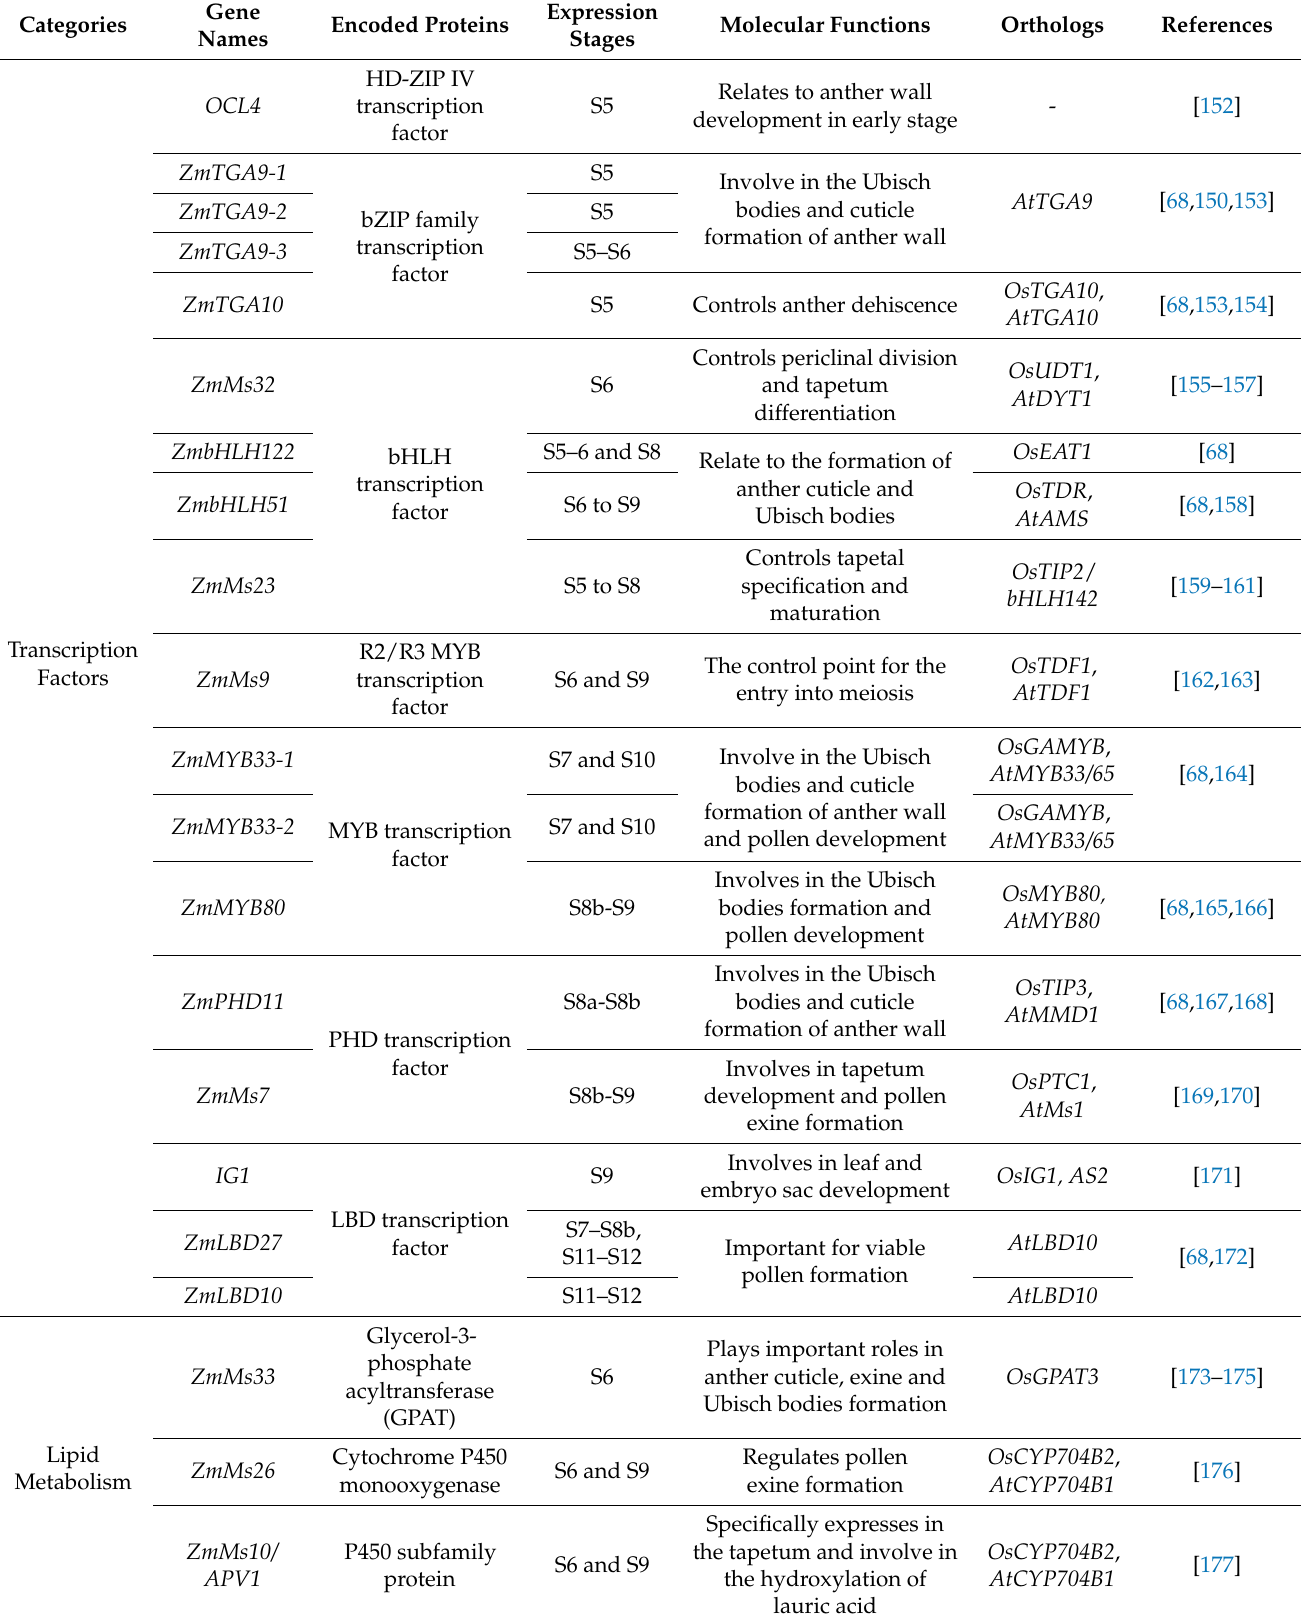
Table 2. Summary of the known GMS genes in